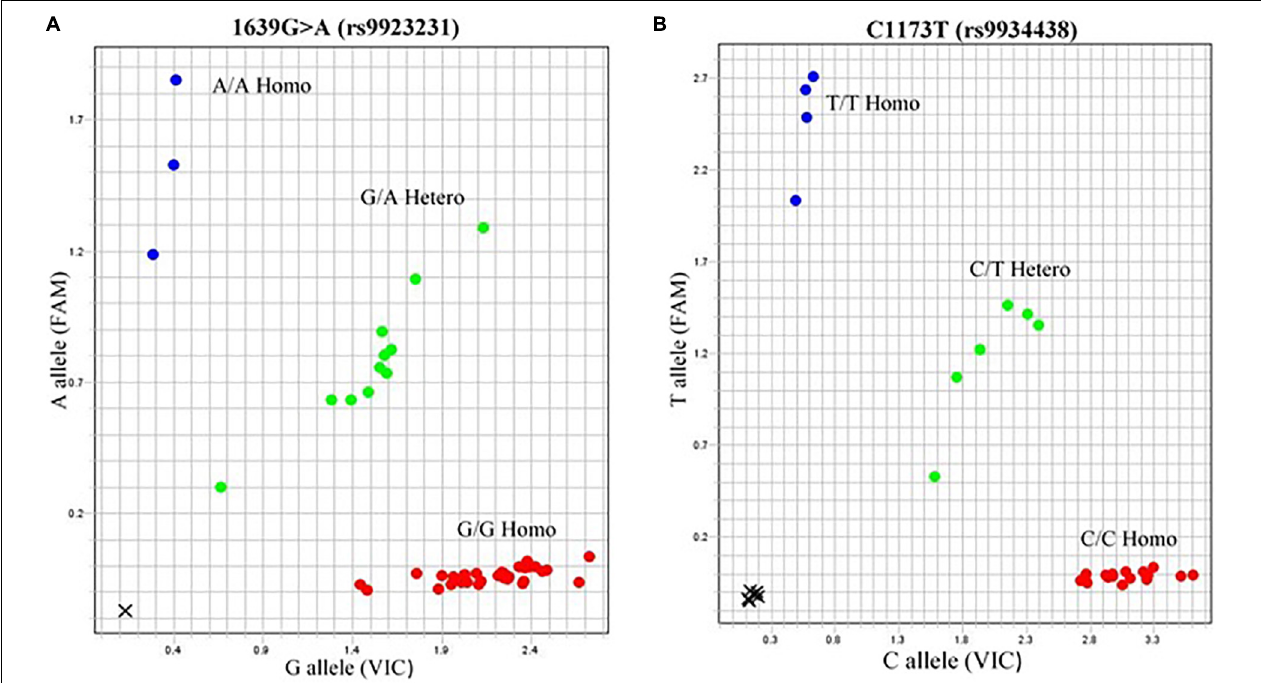
FIGURE 2 | Allelogram showing VKORC1 SNPs. 1639G > A (rs9923231) and C1173T (rs9934438) represented as heterozygous GA and CT phenotypes are in green dots obtained by TaqMan SNP genotyping assay. The genotype of samples of rs9923231 was further confirmed by direct sequencing.